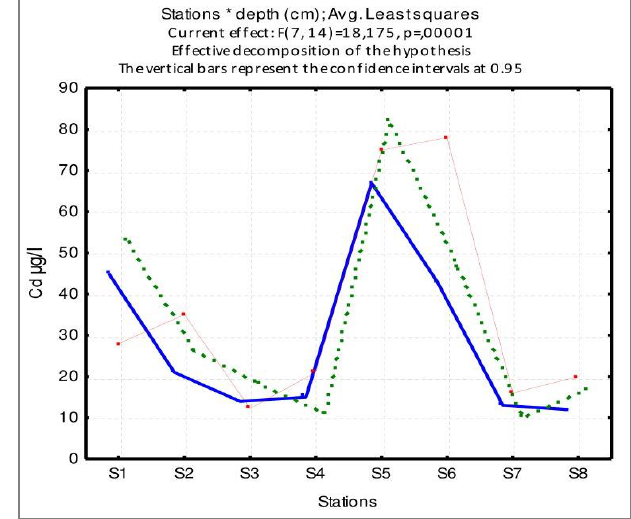
Figure 12. Spatial variation of Cd in μg / l in Reghaia lake. The levels of lead are variable from one station to another ( Figure 13 ), the maximum value is 0.059 mg/L recorded in station S8P3. The minimum value is stored in the S5P1 station (0.01mg / L). Pb values well exceed WHO standards [24] with P = 0.001771.